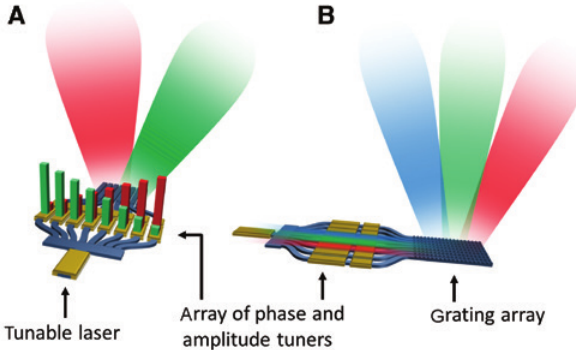
Figure 9: Operation principle of OPAs using wavelength steering. (A) By applying and changing a linear phase profile over the phase tuners, the beam is formed and steered in a direction perpendicular to the grating emitters. Red and green bars schematically indicate the amount of phase tuning. (B) In the direction of the grating emitter, the beam is steered by changing the wavelength of the light, using a tunable laser. Three different wavelengths are sche- matically shown in red, green, and